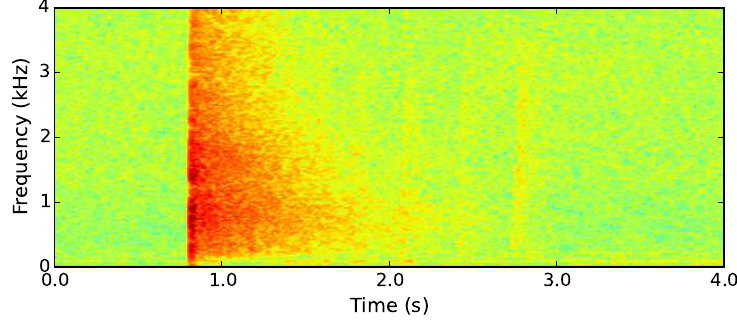
Figure 10. Spectrogram showing the third target sound—a gunshot recorded in the rainforest at a distance of 255